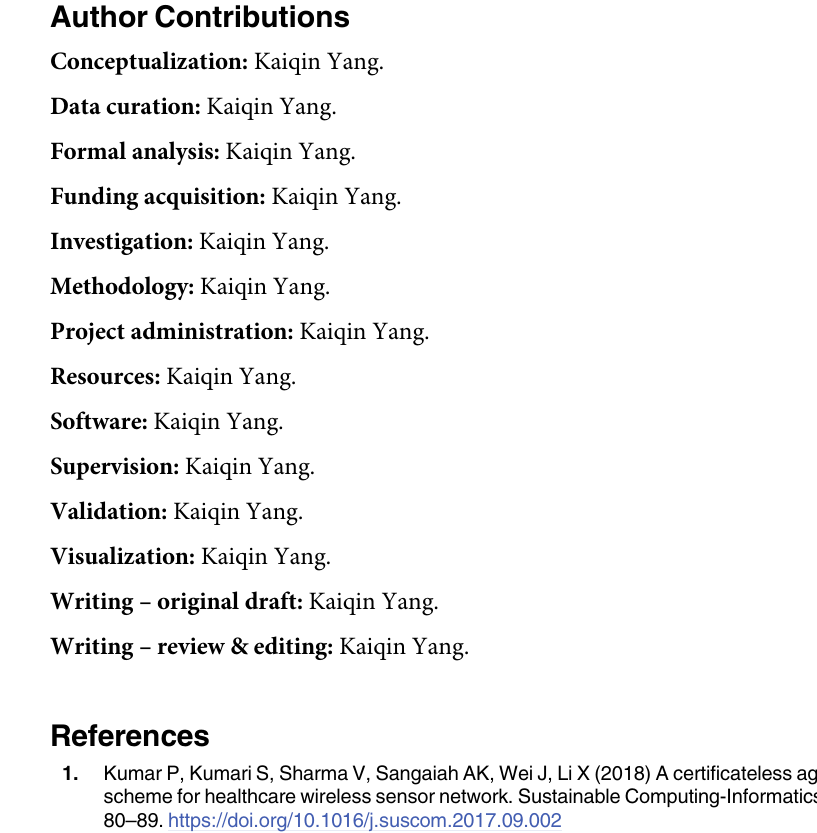
S1 Table. The execution time of cryptographic operations. S1 Fig. Comparison of the computational cost of CLDS schemes. S2 Fig. Comparison of communication overhead of CLDS